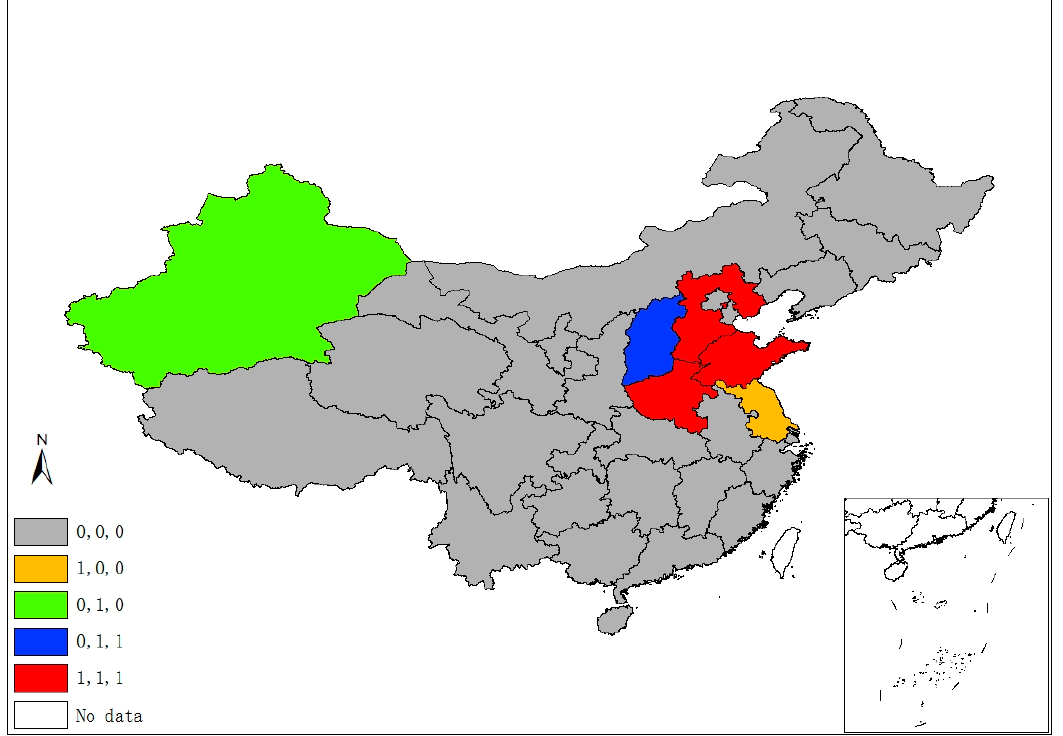
Figure 2. Spatiotemporal significant spots of SO 2 emissions.